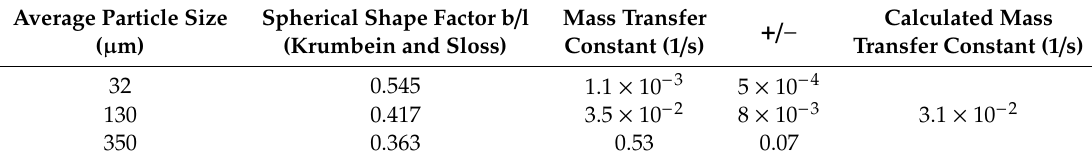
Table 1. The experimentally determined and calculated mass transfer constants of resveratrol as a function of particle size.